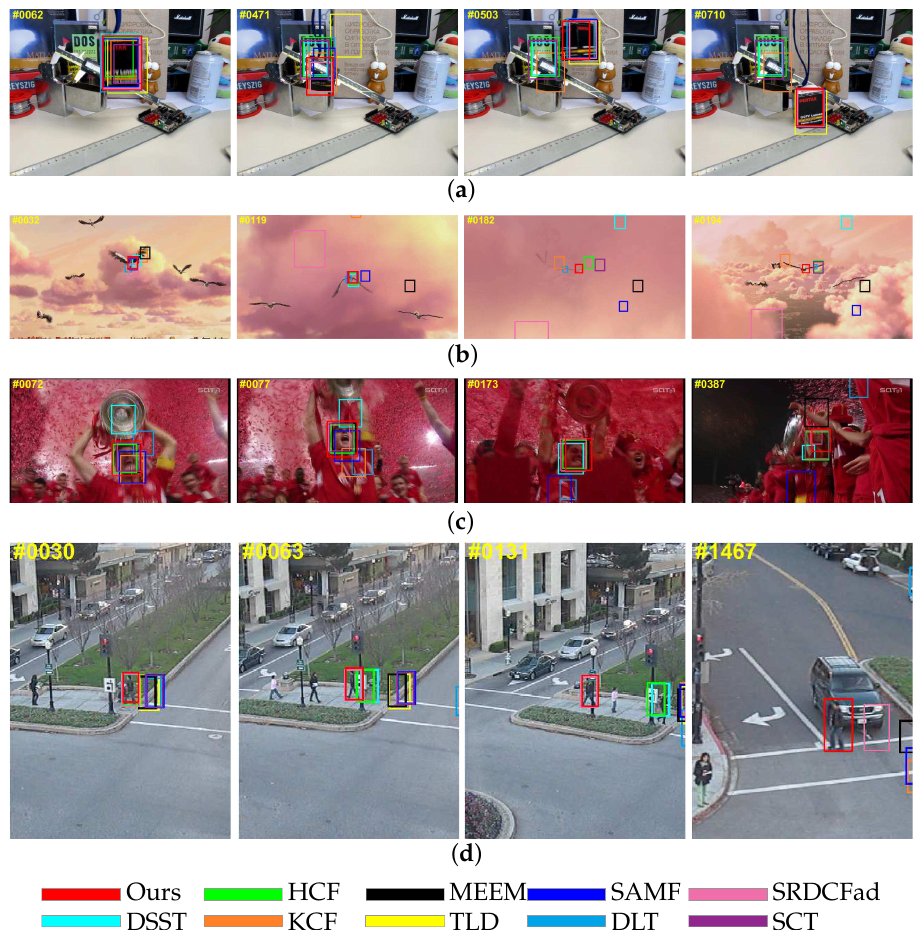
Figure 6. Tracking results on sequences with attributes of occlusion and background cluster. From top to bottom, the name of the video is ( a ) Box; ( b ) Bird1; ( c ) Soccer; ( d )